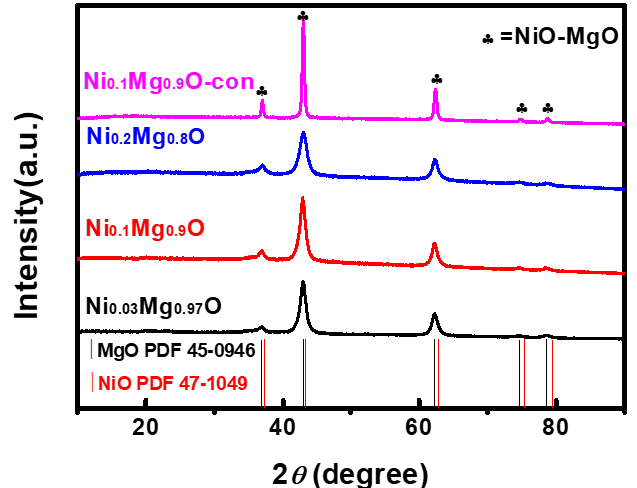
Figure 1. The XRD patterns of the Ni 0.03 Mg 0.97 O, Ni 0.1 Mg 0.9 O, Ni 0.2 Mg 0.8 O, and Ni 0.1 Mg 0.9 O-con catalysts.